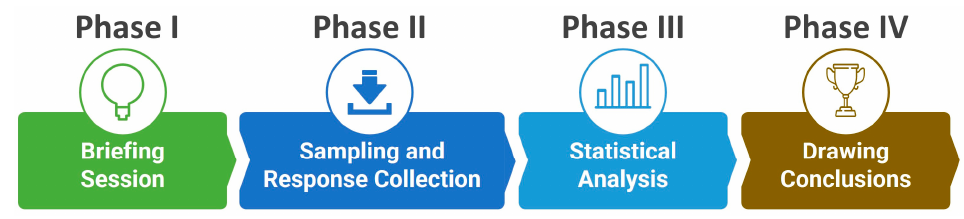
Figure 5. Research